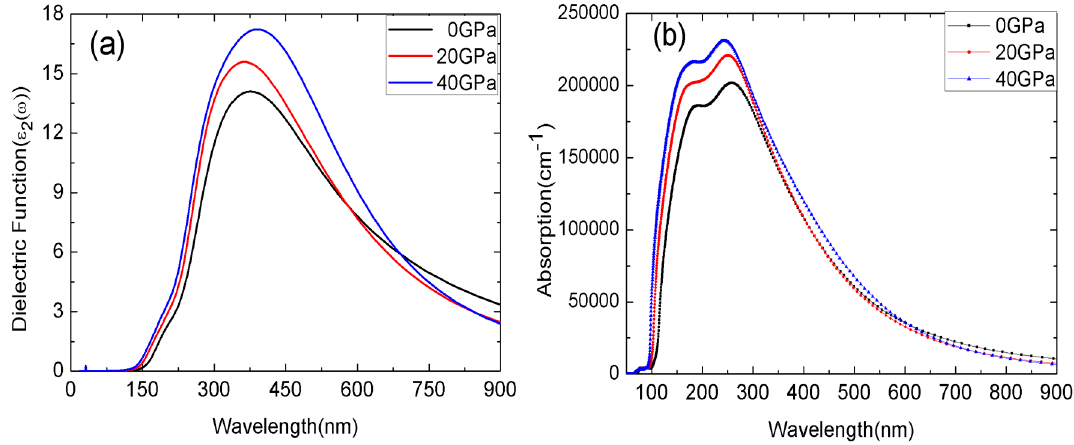
Figure 5. ( a ) The imaginary part of the dielectric function for the TcP 4 crystal at different pressures. ( b ) The absorption coefficient of TcP 4 crystal at different pressures.